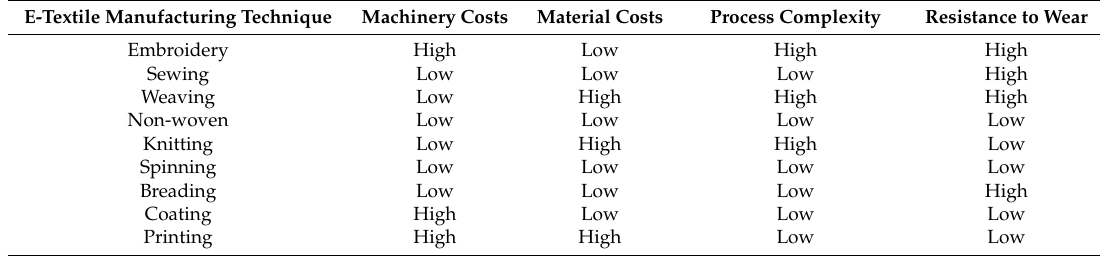
Table 1. Qualitative comparison of e-textiles fabrication